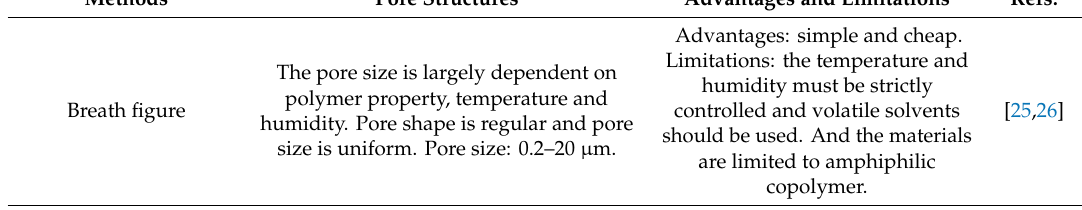
Table2. Theadvantagesandlimitationsofexistingmethodsforpreparingwell-orderedporoussca ff olds.